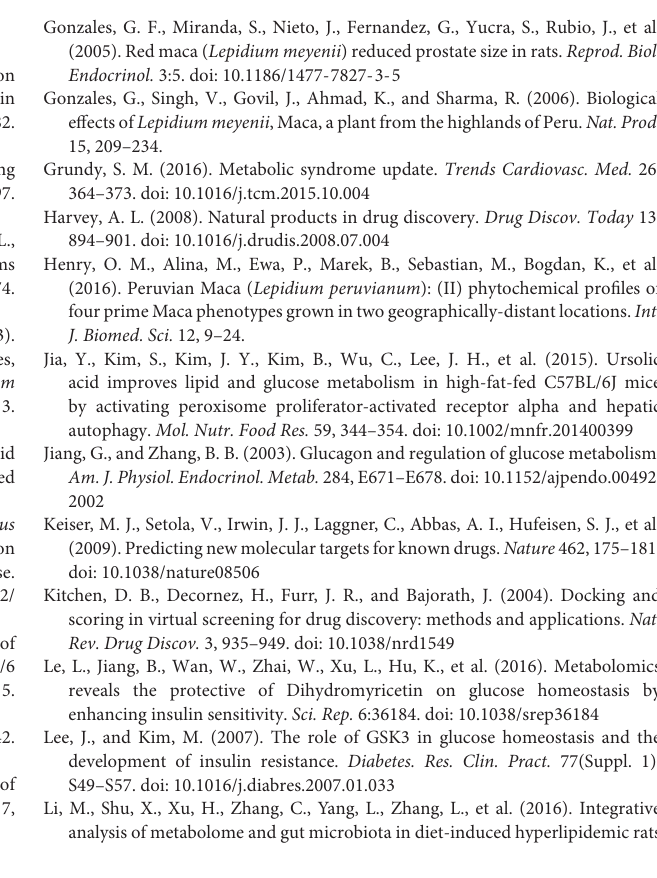
FIGURE S1 | Effects of aqueous extract of black maca (AEM) on the food intake and body weight of golden hamsters over 20 weeks. (A) Daily food intake of each golden hamster. (B) The body weight of each golden hamster over the 20 weeks. Data are presented as the means ± SEMs, n = 6. FIGURE S2 | Number of epididymal white adipocytes per field of vision. The number of epididymal white adipocytes per field of vision was measured. Three fields of vision of each pathology sections were selected randomly. Each field of vision was observed at a magnification of 400 × , n = 4. FIGURE S3 | Effects of aqueous extract of black maca (AEM) on serum lipid profiles and glucose and insulin levels in golden hamsters over 20 weeks. (A) At the end of 4 weeks, serum CHO, TG, LDL, HDL, and glucose levels were tested. (B) At the end of 8 weeks, serum CHO, TG, LDL, HDL, and glucose levels were measured. (C) At the end of 12 weeks, serum CHO, TG, LDL, HDL, and glucose levels were tested. (D) At the end of 16 weeks, serum CHO, TG, LDL, HDL, and glucose levels were measured. Data are presented as the means ± SEMs. # P < 0.05, ## P < 0.01, ### P < 0.001 compared with the control group; ∗ P < 0.05, ∗∗ P < 0.01, ∗∗∗ P < 0.001 compared with the HFD model group, n = 6. TABLE S1 | Hamster quantitative real-time PCR primer sequences. TABLE S2 | Major compound-target-disease table for maca. FILE S1 | The collection of chemical constituents of